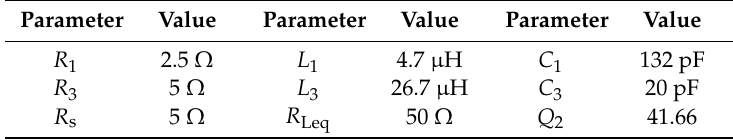
Table 1. Parameters of the WPT system.